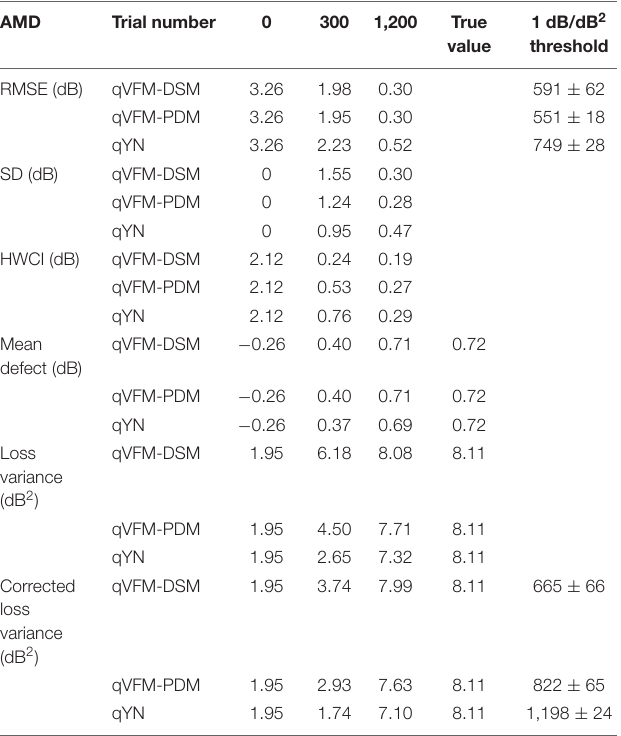
TABLE 4 | RMSE, SD, average 68.2% HWCI, mean defect, loss variance and corrected loss variance of the estimated VFM from the qVFM-DSM, qVFM-PDM and qYN methods in the beginning (0 trial), after 300 and 1,200 trials are listed for the simulated AMD observer. AMD Trial number